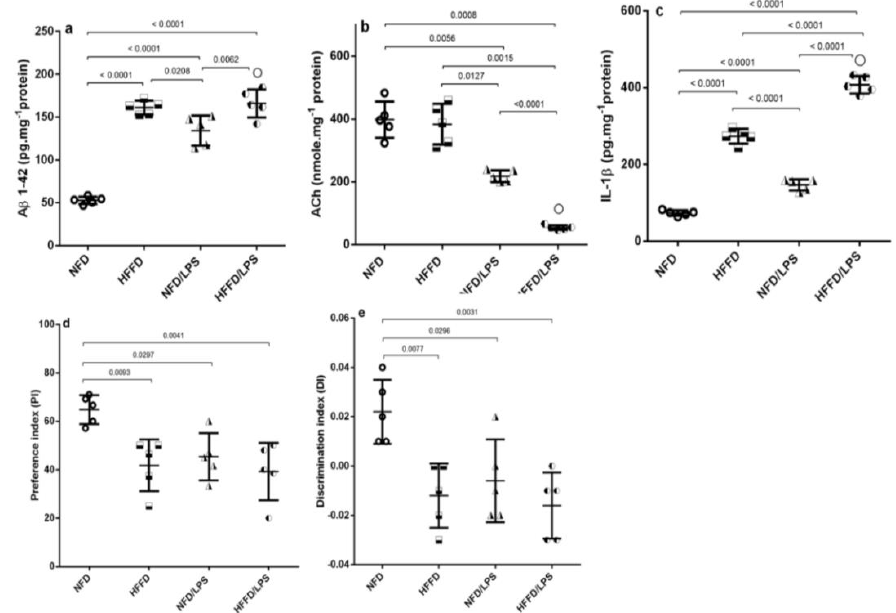
Figure 2. Effects of LPS and/or HFFD on hippocampal content of ( a ) A β 1-42, ( b ) ACh, ( c ) IL-1 β , and ( d , e ) PI/ DI during NOR test in rats after 9 weeks. Values are shown in scatter plots and expressed as mean ± SD ( n = 5/group). All parameters were analyzed using one-way ANOVA followed by Tukey ’ s post hoc test, while Welch ’ s ANOVA was performed followed by Dunnett ’ s T3 Multiple Comparison test for ACh to account for heterogeneity; p < 0.05. ( ○ ) indicates synergistic interaction using coefficient drug index (CDI). Rats were fed NFD or HFFD for 8 weeks and then received or not a single dose of LPS (2 mg·kg -1 , i.p). All groups continued NFD for another week. Aβ1 -42: amyloid beta 1-42; ACh: acetylcholine; DI: discrimination index; IL- 1β: interleukin 1 beta; NOR: novel object recognition; PI: preference index.